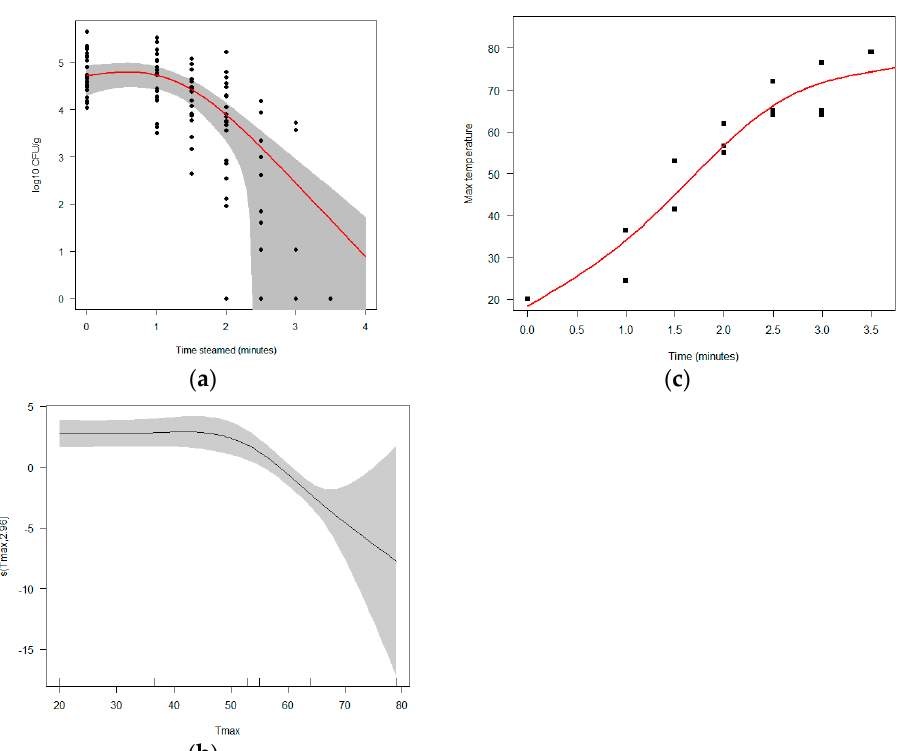
Figure 4. ( a ) Log 10 bacterial concentrations of E. coli as a function of steaming times. The red line gives the best model for inactivation by steaming, with the 2SE confidence interval in gray. ( b ) Maximum temperature registered on loggers glued inside mussel shells as a function of steaming time. ( c ) The effect of maximum temperature on viable bacterial concentration (see equations in Section 2.5). We see that it suggests inactivation from a threshold value a little over 55 ◦